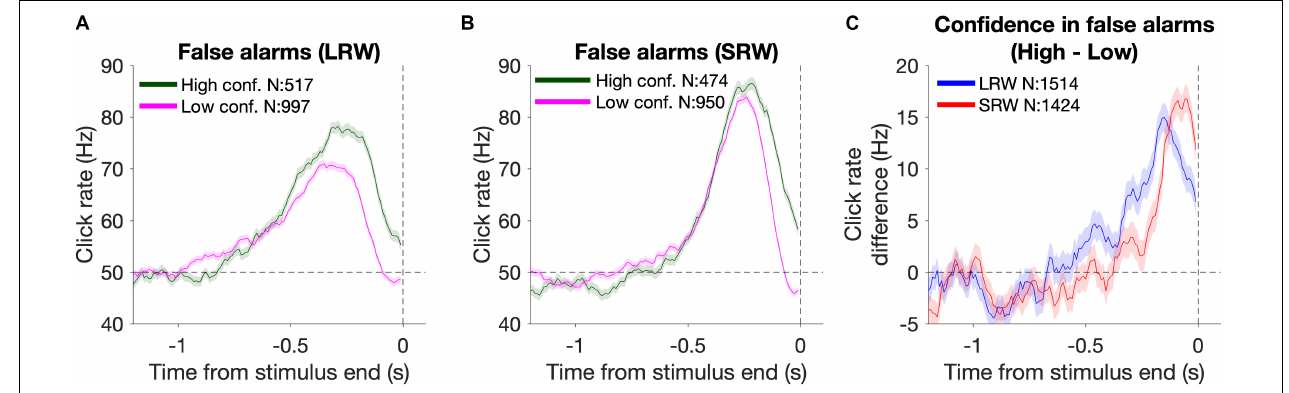
FIGURE 4 | Changes in confidence evaluation timescales based on task condition. (A,B) Detection report kernels from the LRW and SRW conditions, respectively, sorted by the subsequent confidence judgment. (C) Confidence judgment kernels show the time periods when high confidence had a higher click rate than low